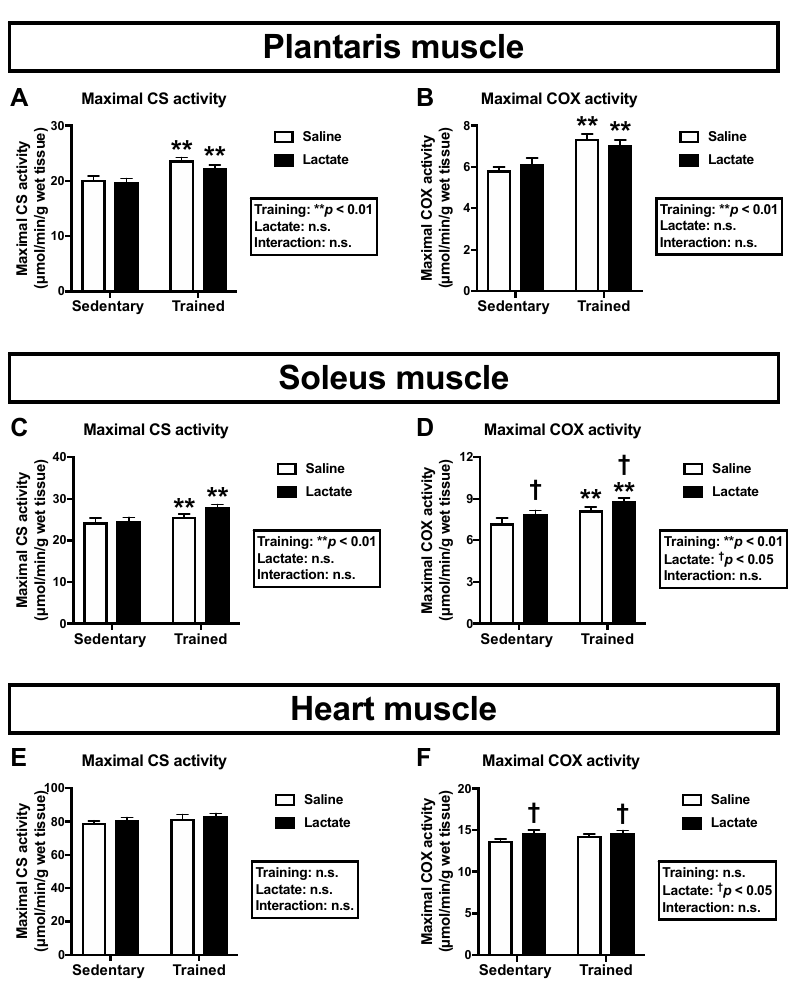
Figure 2. Maximal activities of CS ( A , C , E ) and COX ( B , D , F ) in the plantaris muscle ( A , B ), the soleus muscle ( C , D ), and the heart muscle ( E , F ) following 4-week lactate ingestion. Data are presented as means ± SEM ( n = 8–9). ** p < 0.01: main effect of endurance training. † p < 0.05: main effect of lactate ingestion.